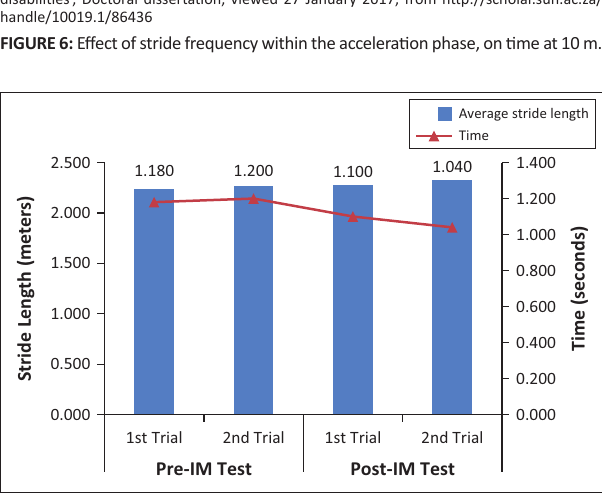
FIGURE 7: Effect of the average stride length during 10 m of the maximal running velocity phase, on time.